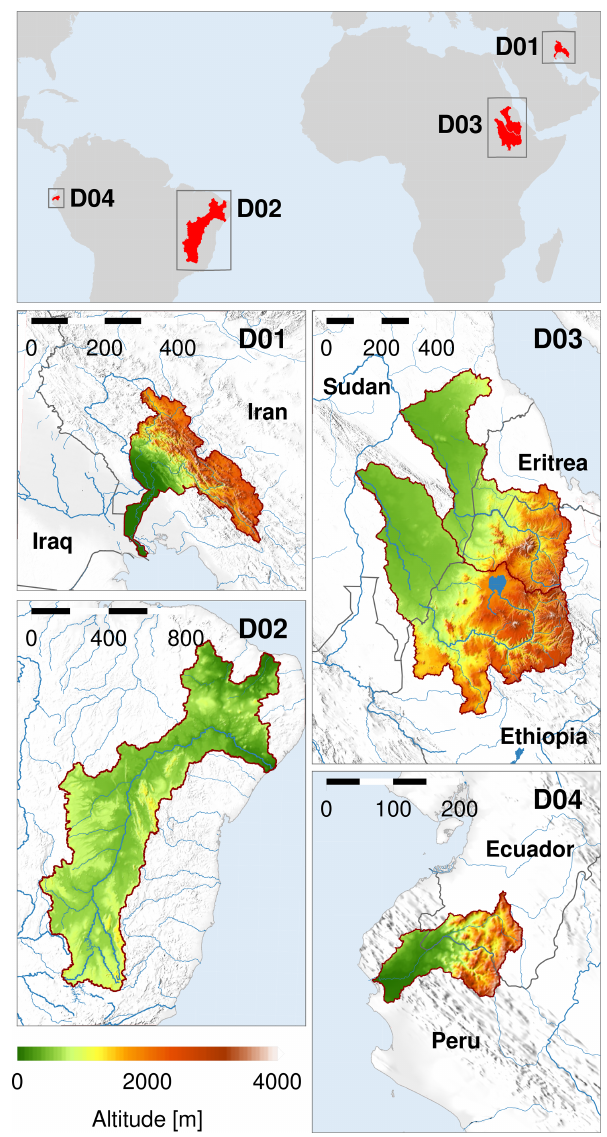
Figure 1. Overview of the four study domains: the Karun Basin (KA, Iran, D01, top left), the Extended São Francisco Basin (SF, Brazil, D02, bottom left), the Tekeze–Atbara (to the north) and Blue Nile (to the south) basins (TA and BN, Sudan, Ethiopia and Er- itrea, D03, top right), and the Catamayo–Chira Basin (CC, Ecuador and Peru, D04, bottom right). The distance scales in the top left corner of the maps are given in units of kilometers. The basin to- pography is based on the high-resolution ETOPO1 Global Relief Model (Amante and Eakins, 2009), while coastlines, rivers and po- litical borders are taken from the Global Self-consistent, Hierar- chical, High-resolution Geography Database (GSHHG, Wessel and Smith, 1996). The basin boundaries are based on the HydroSHEDS dataset (Lehner and Grill, 2013) with some slight modifications and adjustments for ensuring the consistency with boundary definitions from local authorities and stakeholders from the study